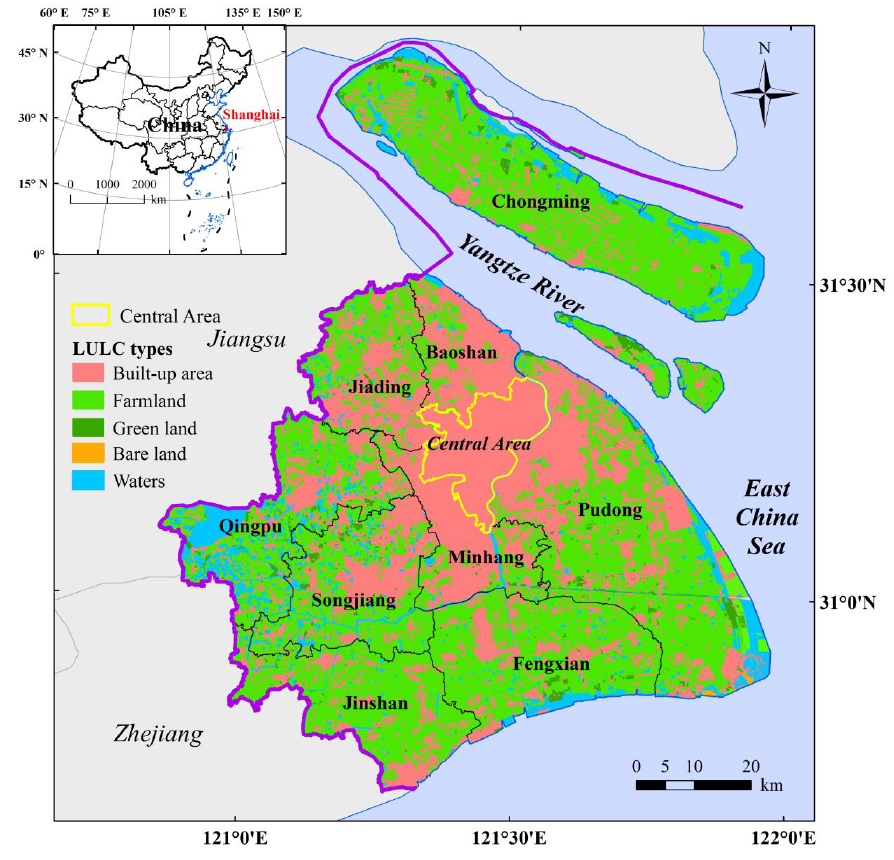
Figure 1. LULC types of Shanghai in 2010.